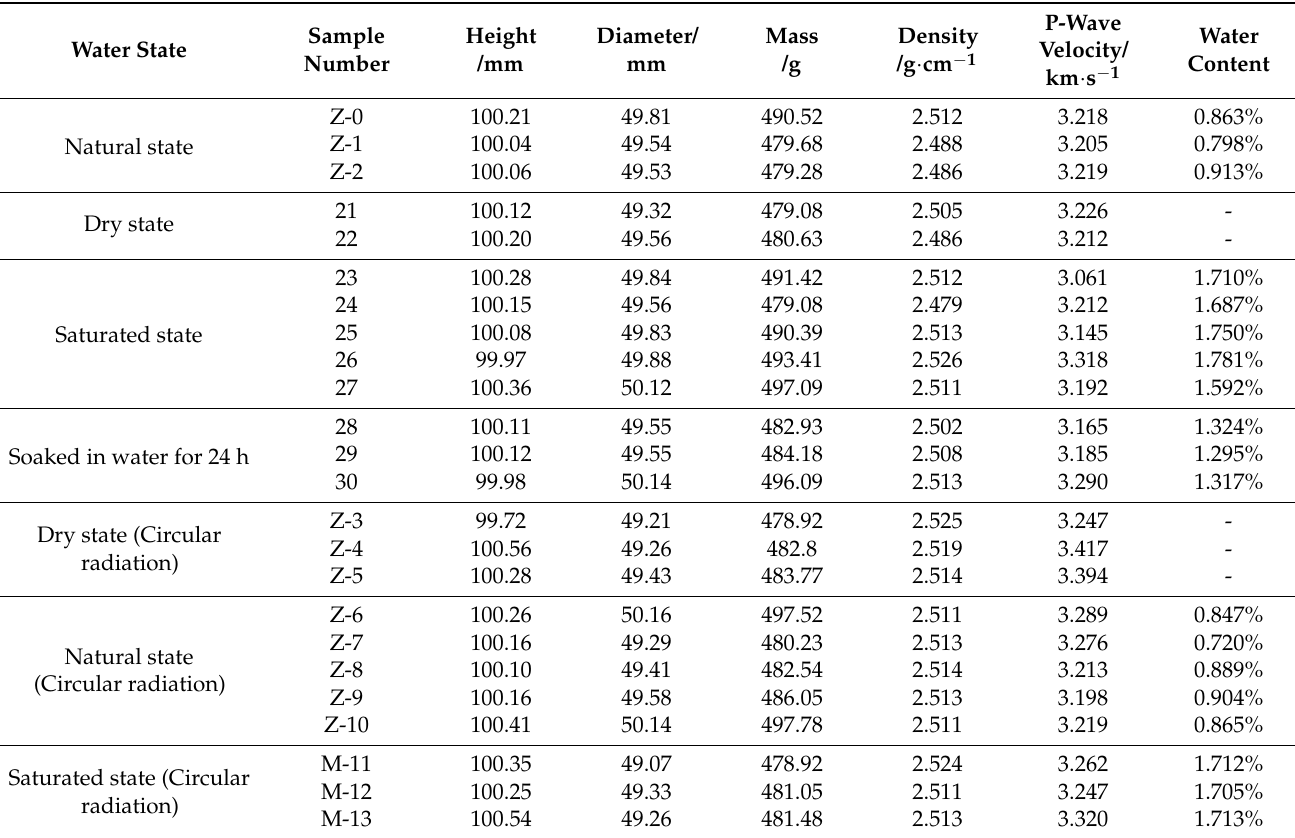
Table 1. Basic physical parameters of samples and their experimental